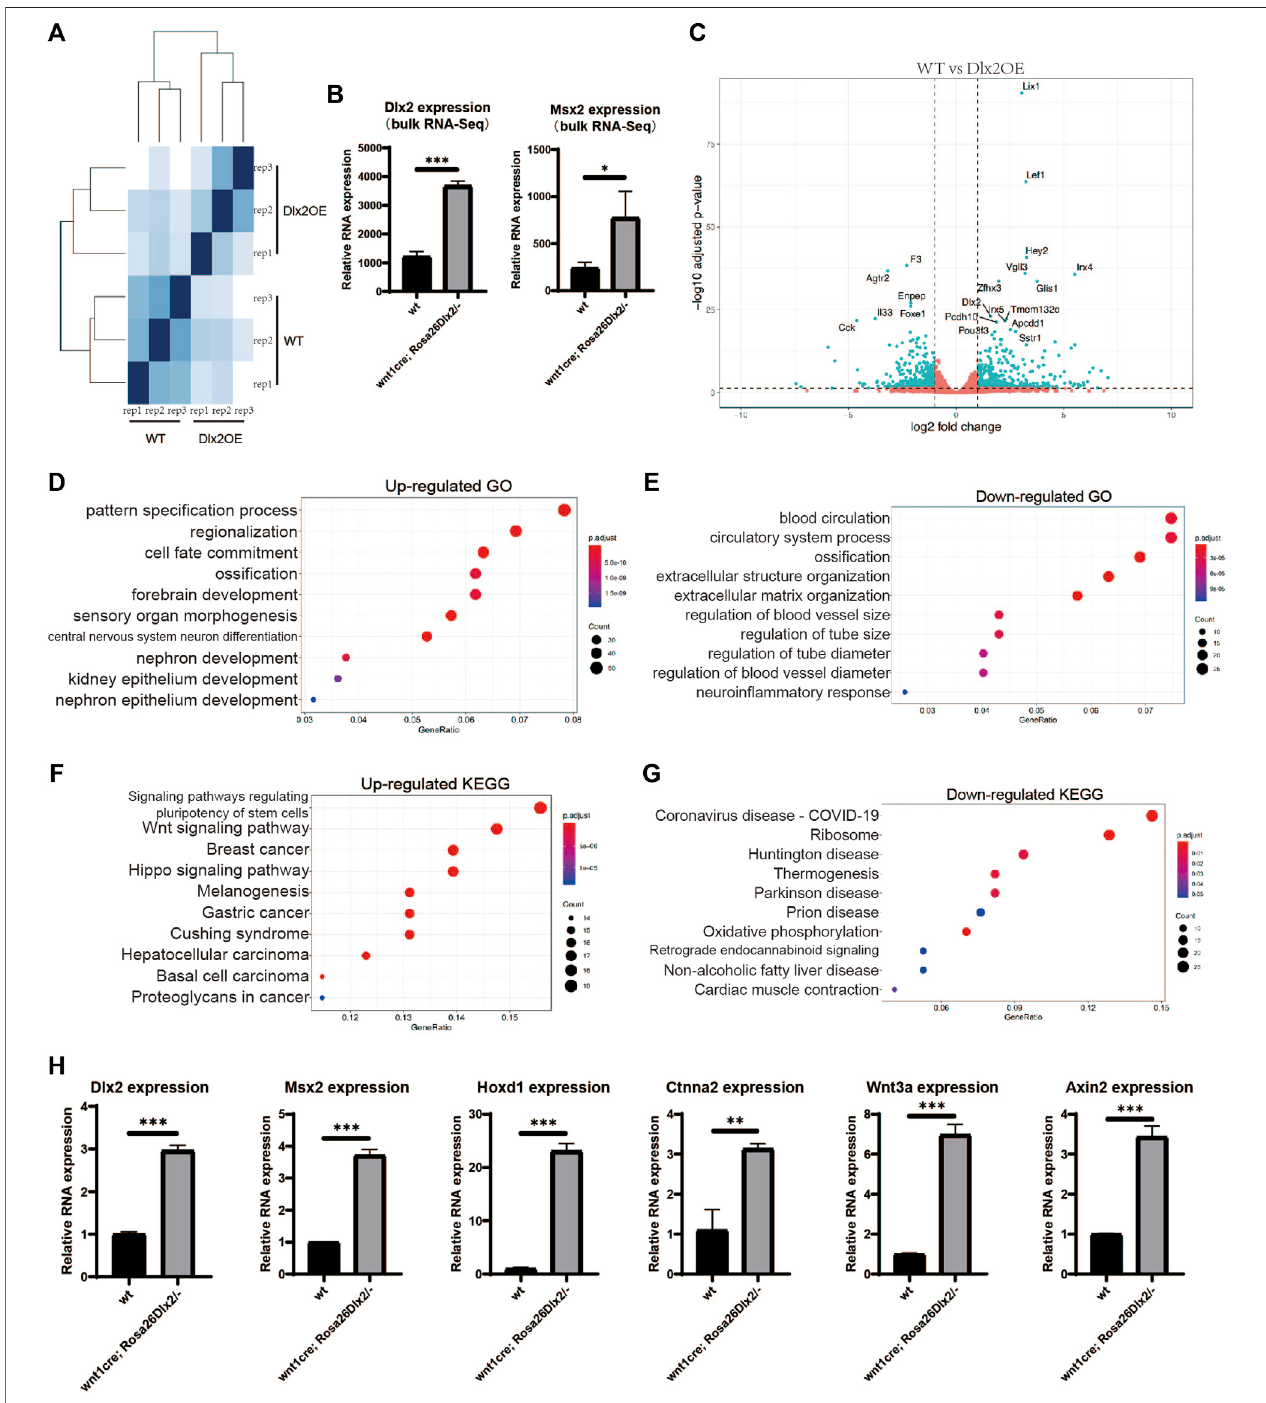
FIGURE 6 | Bulk RNA-seq of the maxillary processes from E12.5 WT and wnt1 cre ; Rosa26 Dlx2/- embryos (A) Sample distances matrix showing the correlation between RNA-seq replicates (B) Bar graphs showing the Dlx2 and Msx2 expression levels in WT and wnt1 cre ; Rosa26 Dlx2/- samples according to bulk RNA-seq. (C) Volcano plots show differentially expressed genes between WT and wnt1 cre ; Rosa26 Dlx2/- samples (D,E) GO enrichment analysis of genes signi fi cantly upregulated or downregulated in wnt1 cre ; Rosa26 Dlx2/- (F,G) KEGG pathway enrichment results for genes signi fi cantly upregulated or downregulated in wnt1 cre ; Rosa26 Dlx2/- (H) Bar graphs show the Msx2, Hoxd1, Ctnna2, Wnt3a and Axin2 expression levels in WT and wnt1 cre ; Rosa26 Dlx2/- samples according to qPCR.